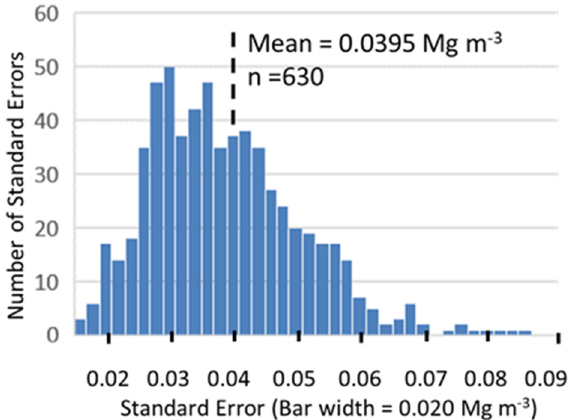
Figure 6. Histogram of all the standard errors reported in Table 2. Seven values between 0.095 and 0.150 g m − 3 are not shown. Each value of standard error is based on 16 individual soil cores (Table 2).